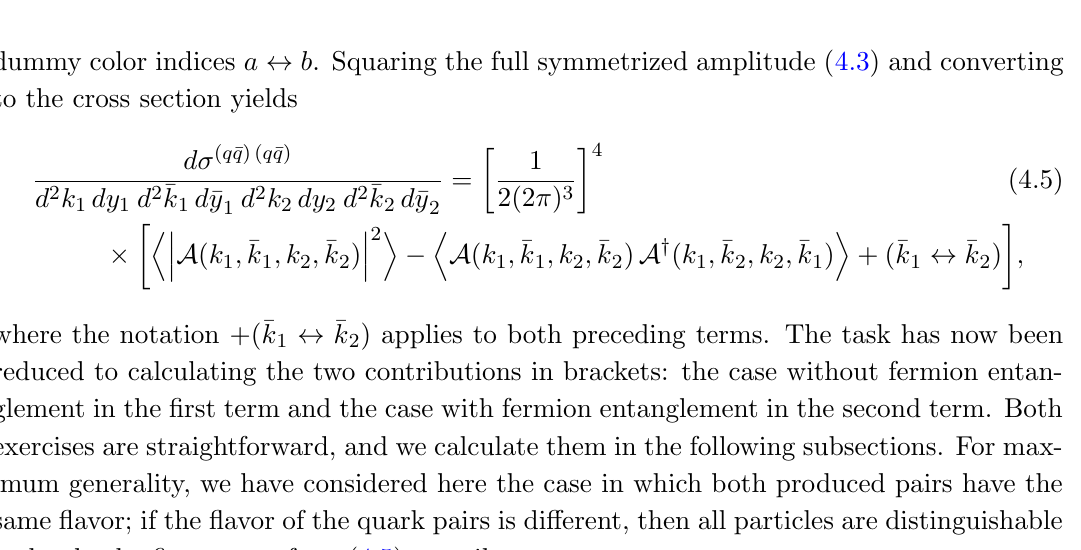
Figure 4 . Double-pair production topologies without fermion entanglement, as calculated in eq.